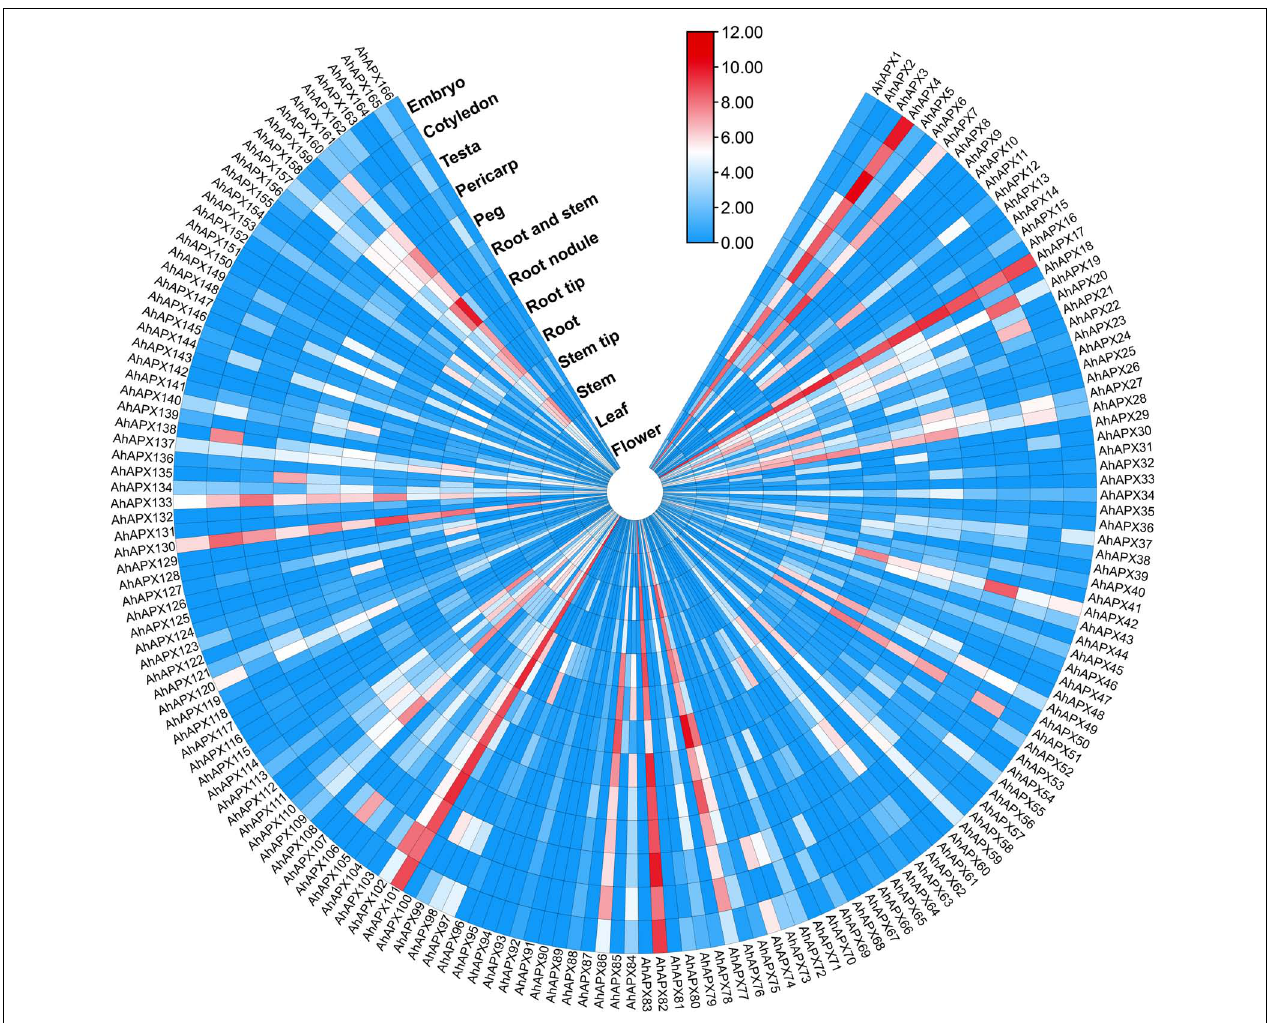
FIGURE 11 | Expression profiling of AhAPX genes in various developmental tissues of peanut. In the expression bar, the red, white and blue colors show high to low expression levels. The circular heat map was designed by taking log2 of fragments per kilobase of transcript per million (FPKM)